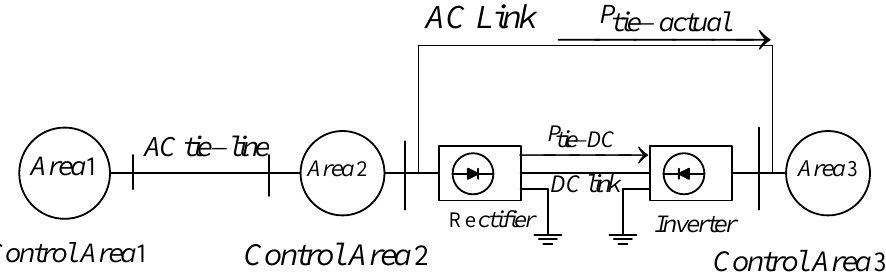
Figure 3. HVDC link connected in area 2 and area 3.